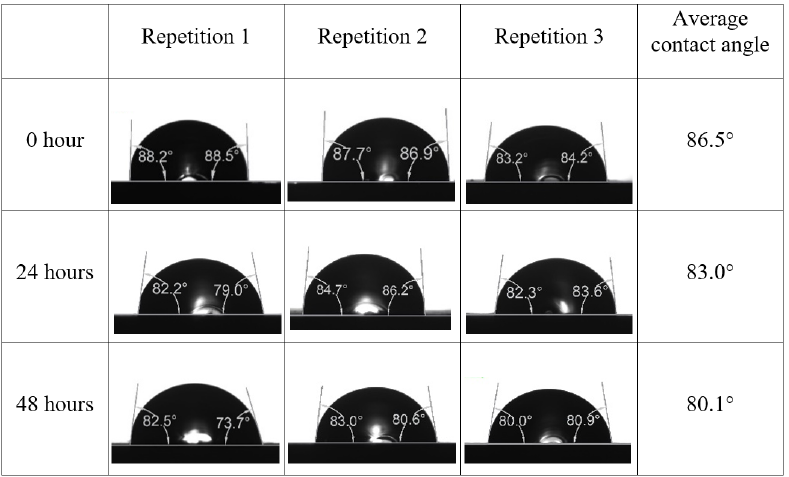
Figure A5. Dynamic Contact Angle Measurement Results for 25% MgCl 2 + 75% NaCl (3500